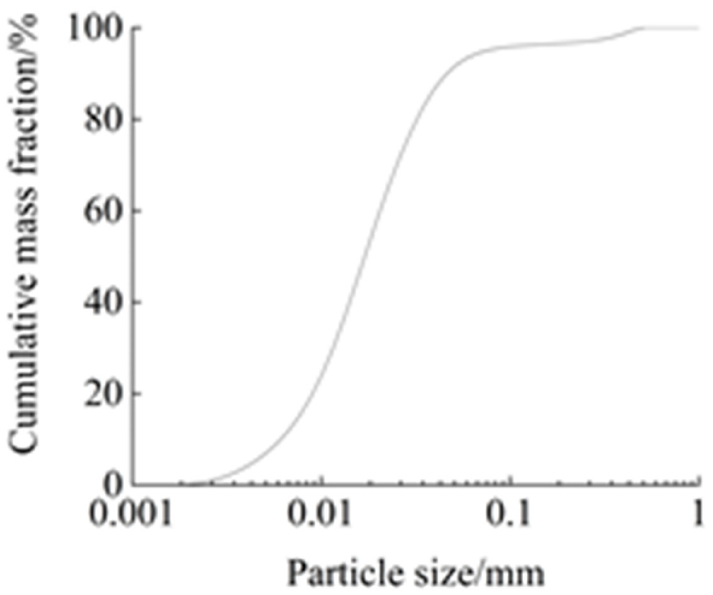
Figure 3. Particle size distribution of silica powder. Table 2. Physical properties parameters of silica powder.